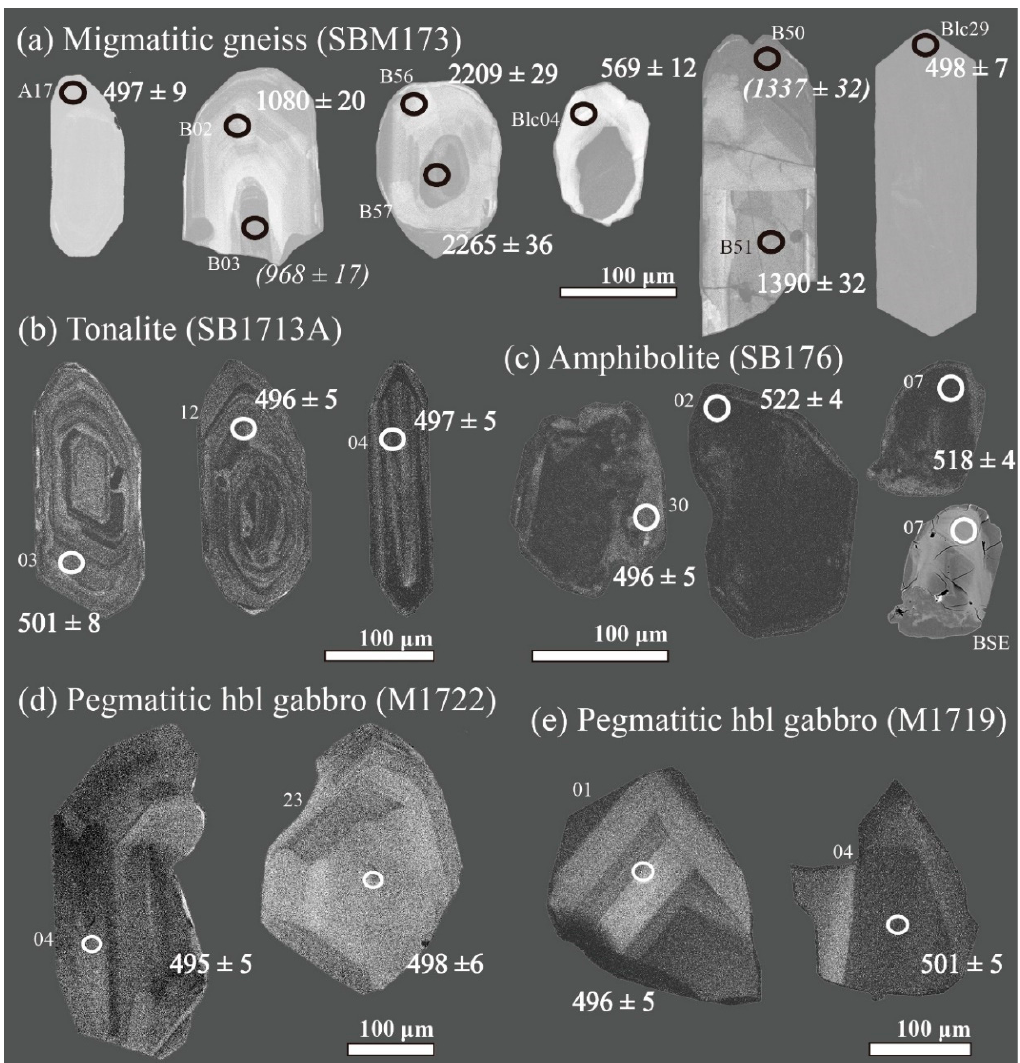
Figure 5. Representative cathodoluminescence (CL) images of zircon and the spots of the SHRIMP U–Pb analyses with 206 Pb / 238 U ages (Ma) ( discordant ages denoted in italics ) of ( a ) migmatitic gneiss (SBM173; Mt. Murchison, WT), ( b ) tonalite (SB1713A; Tonalite Belt), ( c ) amphibolite (SB176; Dessent Unit), ( d ) pegmatitic hornblende (hbl) gabbro (M1722; TGC, BT) and ( e ) pegmatitic hbl gabbro (M1719; TGC, BT). The Paleoproterozoic ages (2209 Ma and 2265 Ma) of the migmatitic gneiss (SBM173) ( a ) are 207 Pb/ 206 Pb ages. The small-sized numbers are the spot numbers in Table S1. One backscattered electron (BSE) image of the amphibolite (SB176) ( c ) is compared with its CL image.